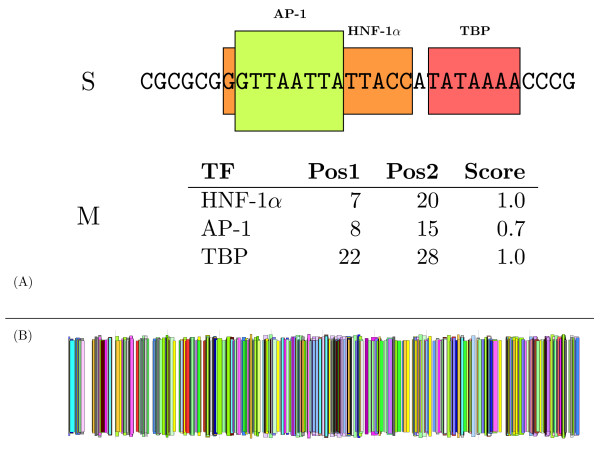
(A) The sequence of a promoter is searched for occurrences of known binding motifs for transcription factors (TFs), using a collection of position weight matrices. Matches are denoted as TF-tuples that contain the label of the TF, the positions of the match in the primary sequence, and the score provided by the corresponding matrix. Because binding sites tolerate sequence substitutions, several overlapping TF-tuples can be identified in a subset of positions. TF-tuples are graphically represented as boxes along the promoter sequence. Each TF is denoted with a different color. (B) Promoter TF-mapping of the phospholipase A1 gene (RefSeq: NM 015900, 500 nucleotides). TRANSFAC 6.3 was used as the mapping function [16]. In both cases, the TF occurrences are displayed as boxes along the promoter. In (A), the boxes are condensed in a single line. The TF-map graphical representation has been produced with the program gff2ps [27].